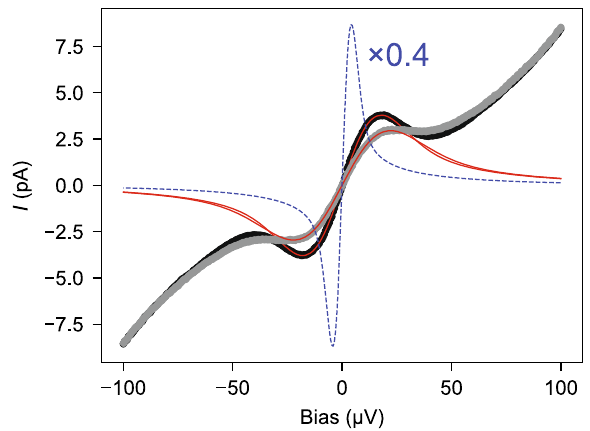
Fig. 4 The lowest temperature Josephson current spectra fi tted using the P ( E ) theory 26 . The black data series depicts the Josephson current I ( V ) spectrum acquired simultaneously with the lowest temperature differential conductance d I /d V curve in Fig. 3 measured at 34 mK and fi tted with the temperature of the environment T env = 1.5 K (red curve, cf. text). Measured by the positions of the I ( V ) extrema in this curve, the broadening due to environmental effects is 35 μ V. The blue dashed line shows the I ( V ) spectrum of a junction in a well-thermalized environment obtained with the same parameters as for the black curve (cf. text) but T env = 0.1 K. The corresponding value of environmental broadening is 9 μ V. Gray data correspond to the I ( V ) spectrum of the Josephson junction measured at 34 mK with the high-frequency fi lter of the bias line 12 unplugged. The data were fi tted with T env = 2.3 K, keeping all other parameters unchanged (cf. text). Measured by the positions of the I ( V ) extrema in this curve, the broadening due to environmental effects is 44 μ V.